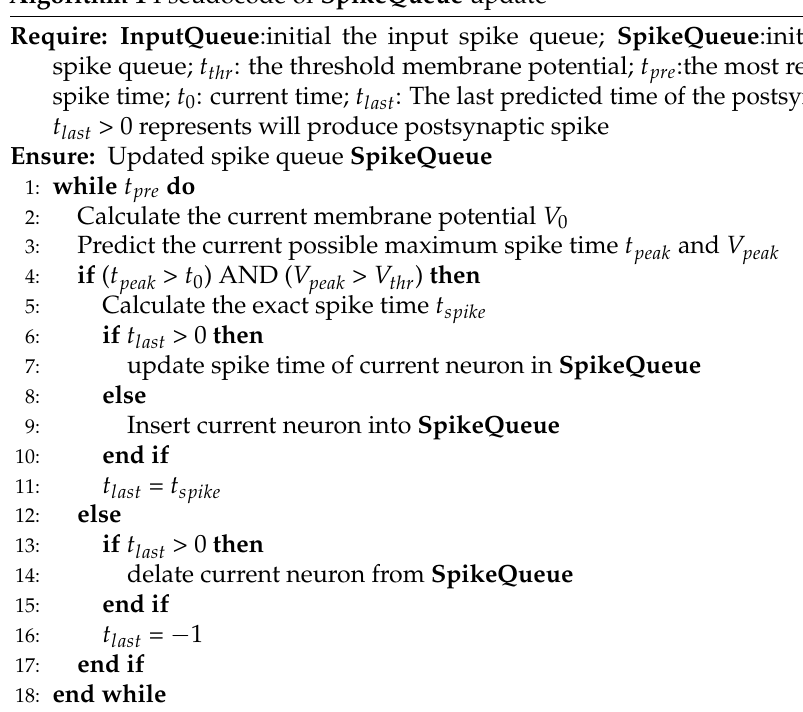
Algorithm 1 Pseudocode of SpikeQueue update